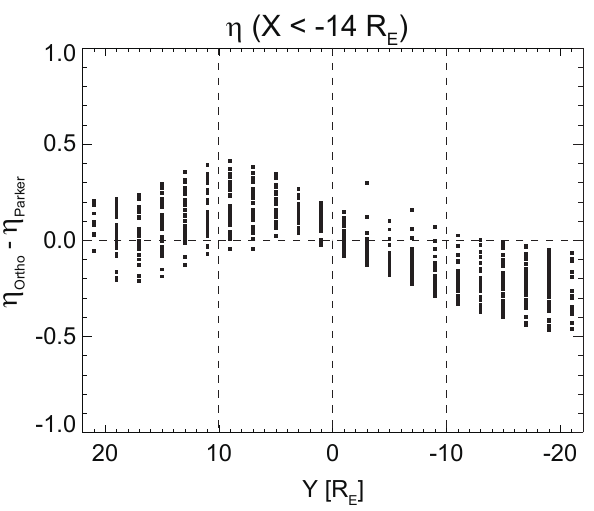
Fig. 14. Y profile of difference of solar wind dependence parameter between Parker and ortho-Parker IMF orientations at X< − 14 R E